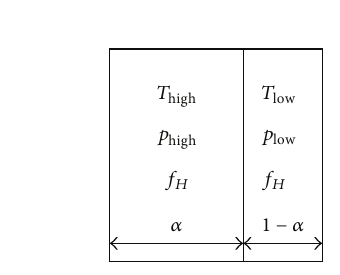
Figure 2: Results of shock-tube calculation with HLLC scheme.